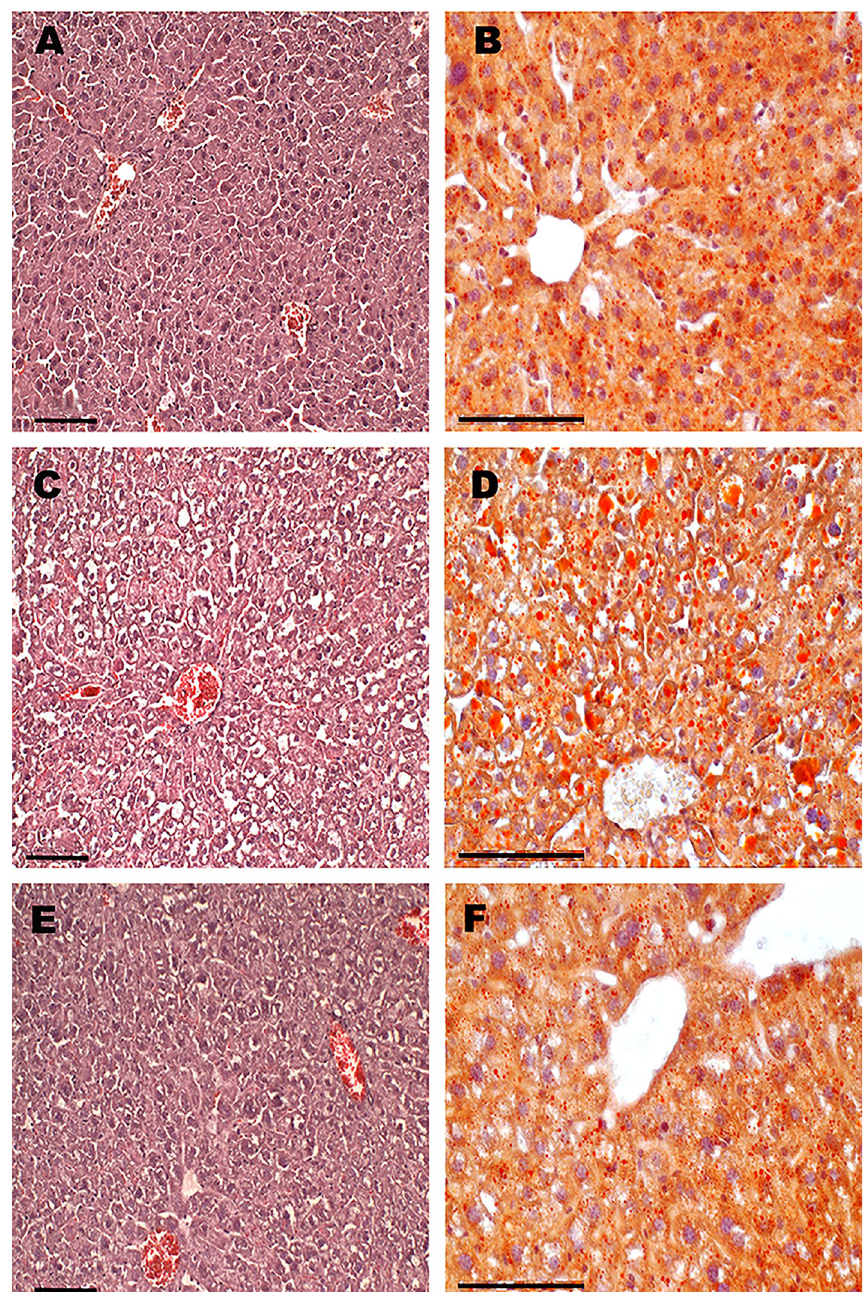
Fig 2. The histological evidence of steatosis in the liver of obese agouti-mice, and the improving effect of long- term metformin treatment (600 mg/kg/day). A, B–Group a/a (control); C, D–Group Ay/a; E, F–Group Ay/a-M600. The liver histology was evaluated using the staining of liver sections with hematoxylin and eosin (A, C, E), while the hepatic lipid deposition was evaluated by the Sudan III-staining (B, D, F). The orange inclusions and granules after the Sudan III staining are the lipid and lipoproteins accumulations located within hepatocytes. The liver sections from animals of each of the three studied groups were mounted on the same glass. Scale bars, 100 μ